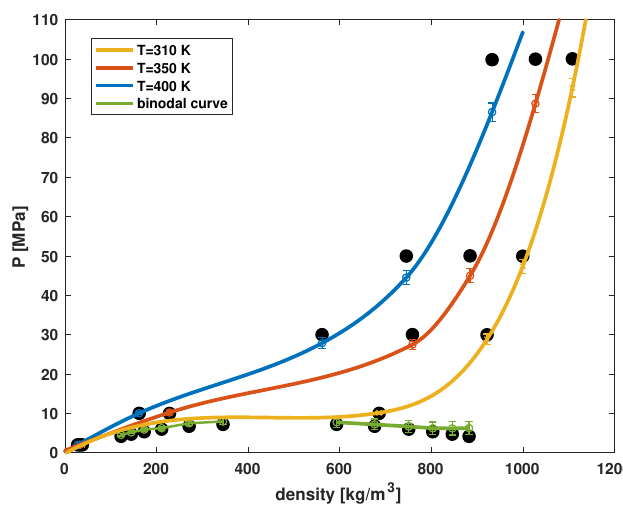
Figure 2. Comparison between simulation predictions (solid lines) and experimental data (solid points).